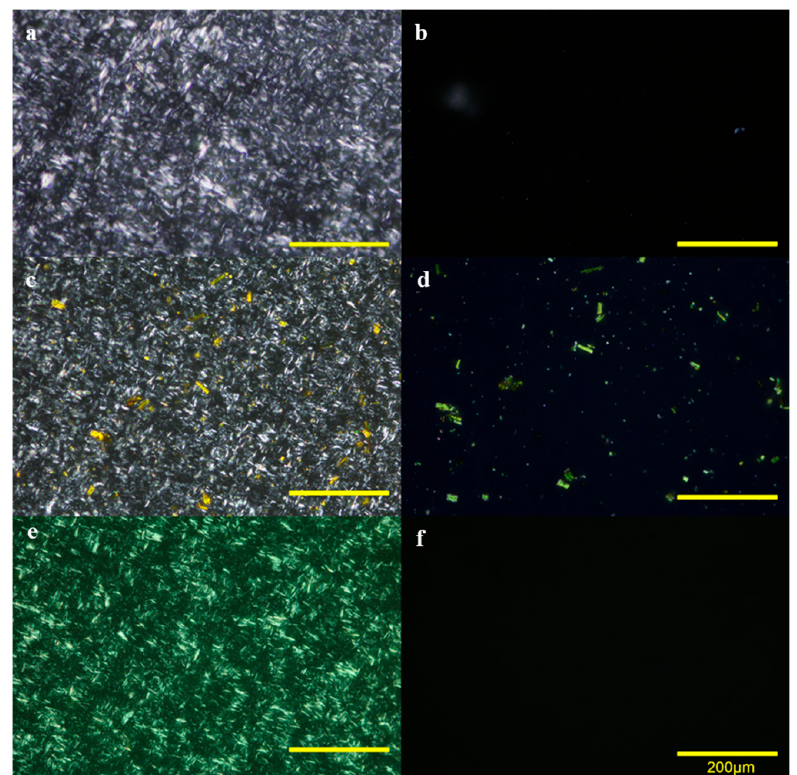
Figure 2. ( a , b ) PLM micrographs for OGCtrl at 20 °C ( a ) and at 80 °C ( b ). ( c , d ) PLM micrographs for Figure 3. ( a , b ) PLM micrographs for OGCtrl at 20 ◦ C ( a ) and at 80 ◦ C ( b ). ( c , d ) PLM micrographs for OGCur, with curcumin dissolved at 70 °C (( c ): organogel at 20 °C; ( d ): organogel at 80 °C). ( e ) and ( f ) OGCur, with curcumin dissolved at 70 ◦ C (( c ): organogel at 20 ◦ C; ( d ): organogel at 80 ◦ C). ( e ) and ( f ) PLM micrographs for OGCur, with curcumin dissolved at 140 °C ( e ): organogel at 20 °C; ( f ): organogel PLM micrographs for OGCur, with curcumin dissolved at 140 ◦ C ( e ): organogel at 20 ◦ C; ( f ): organogel at 80 °C). at 80 ◦